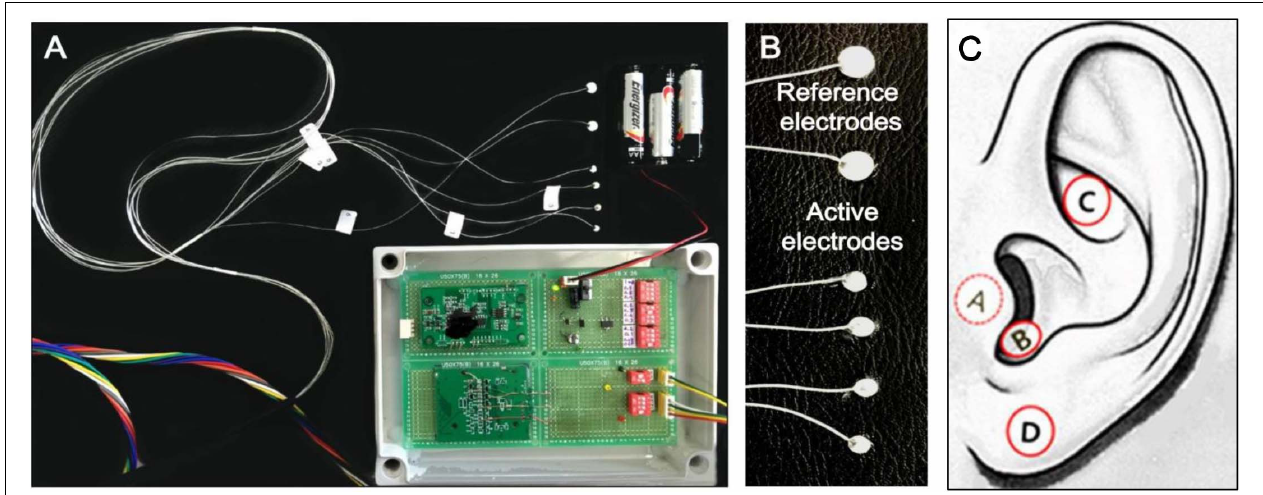
FIGURE 1 | (A) A custom-built MRI-compatible tVNS stimulator used in the tVNS fMRI studies by Yakunina et al., 2017, 2018 (B) Six silver electrodes (four active, two reference electrodes). (C) tVNS stimulation locations: inner surface of the tragus (A), inferoposterior wall of the external acoustic meatus (B), cymba conchae (C), and earlobe (sham;